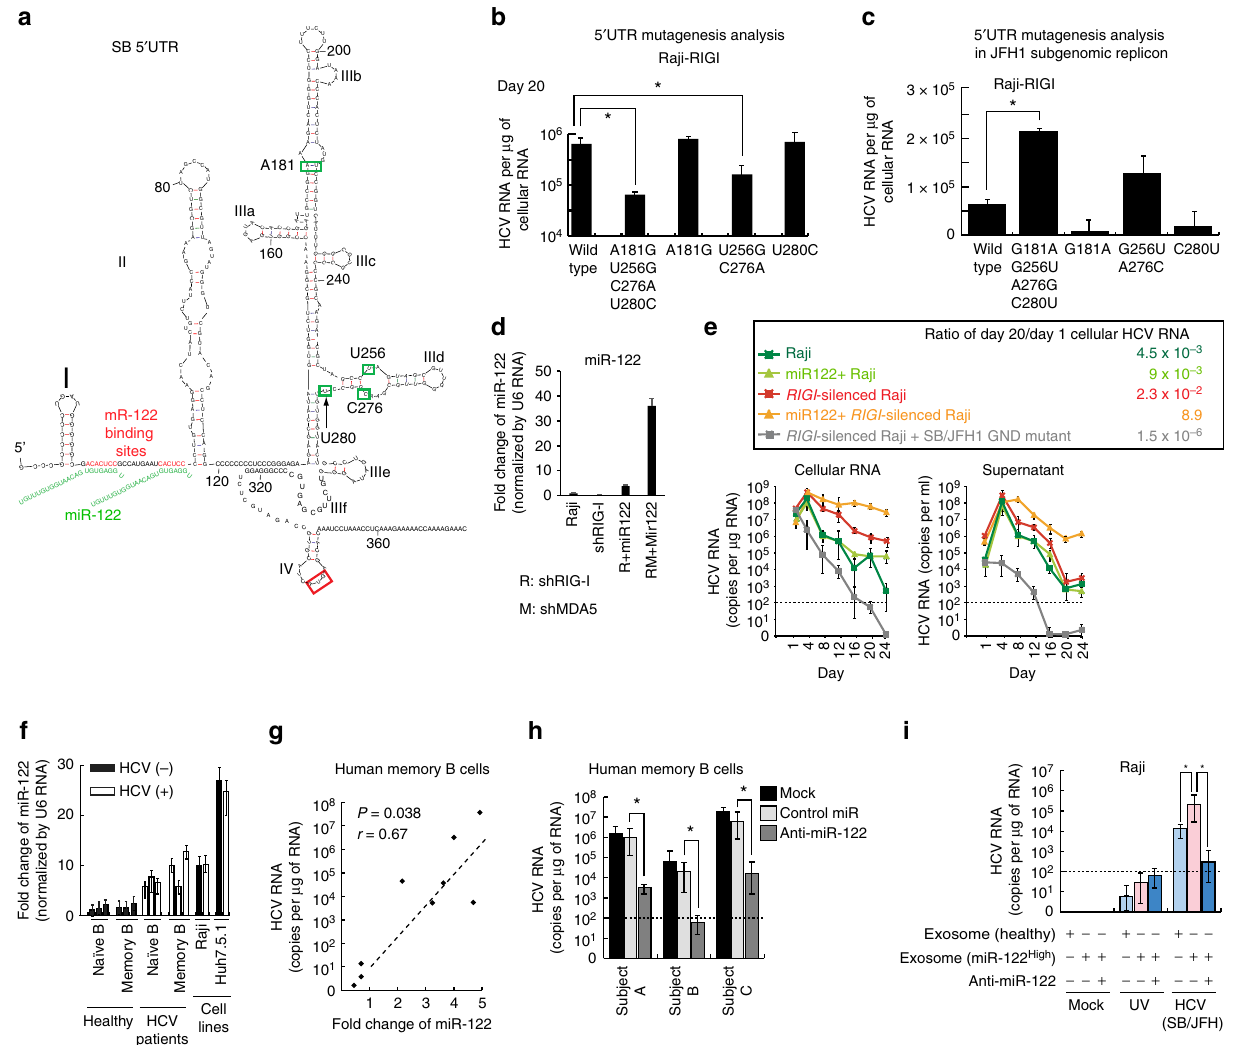
Figure 3 | Sequence of 5 0 -UTR of lymphotropic HCVand cellular miR-122 levels are involved in lymphotropism. ( a ) The putative structure of the 5 0 -UTR of SB-HCV RNA as determined by MFOLD program (computational secondary structure prediction software). The nucleotides in green boxes are those that differ between SB and JFH1 RNA. These nucleotides are located in stem-loops (IIIa and IIId) and bulge regions, which may recruit lymphocyte-specific factors. The nucleotides in red boxes are the first AUG (start codon). miR-122 seed-match sequences (red) and predicted interactions with miR-122 (green) are shown. ( b ) The HCV RNA titers in sh-RIGI-Raji cells transfected with various 5 0 -UTR mutants of SB RNA (* P o 0.05, ANOVA, n ¼ 3). Error bars represent s.d. ( c ) The HCV RNA titers in sh-RIGI-Raji cells transfected with the various 5 0 -UTR mutants of JFH1 subgenomic replicon RNA (* P o 0.05, ANOVA, n ¼ 3). Error bars represent s.d. ( d ) miR-122 expression levels in Raji cells transduced with lentivirus expressing shRIGI, sh-MDA5 or mir-122 ( n ¼ 3). Error bars represent s.d. ( e ) Transduction of microRNA miR-122 enhances and stabilizes HCV replication in B lymphocytes. Effects of RIGI and miR-122 on lymphotropic HCV SB infection were examined using specific shRNA ( n ¼ 3). Error bars represent s.d. ( f ) Human memory B cells have higher levels of miR-122 in clinical specimens. Cellular miR-122 levels were determined by qRT-PCR in quadruplicate in PBMCs from three different patients ( n ¼ 3). Error bars represent s.d. ( g ) Analysis of HCV RNA in B cells versus miR-122 in B cells. The miR-122 levels of B cells from HCV patients were comparable to that of Raji cells. The miR-122 abundance is correlated with higher HCV RNA levels in memory B cells. Cellular HCV RNA levels were determined by qRT-PCR in nine different patient PBMCs. ( h ) Memory B cells from three patients were infected with HCVand cellular HCV RNA levels were determined by qRT-PCR in quadruplicate. (* P o 0.05, Student t -test, n ¼ 3). Error bars represent s.d. ( i ) To determine if miR-122 sequestration reduced HCV replication in B cells, antagomir of miR-122 was transfected into human memory B cells isolated from HCVpatients and examined for cellular levels of HCV RNA in B cells (* P o 0.05, t -test, n ¼ 3). Error bars represent